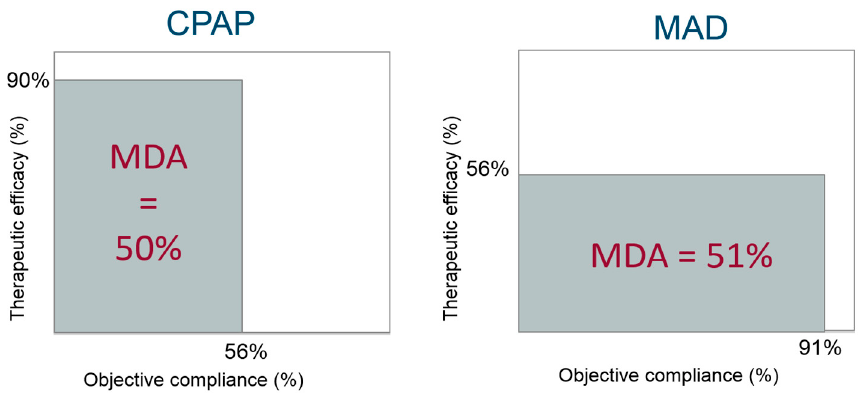
Figure 2. The mean disease alleviation (MDA) for continuous positive airway pressure (CPAP) vs. MAD therapy.